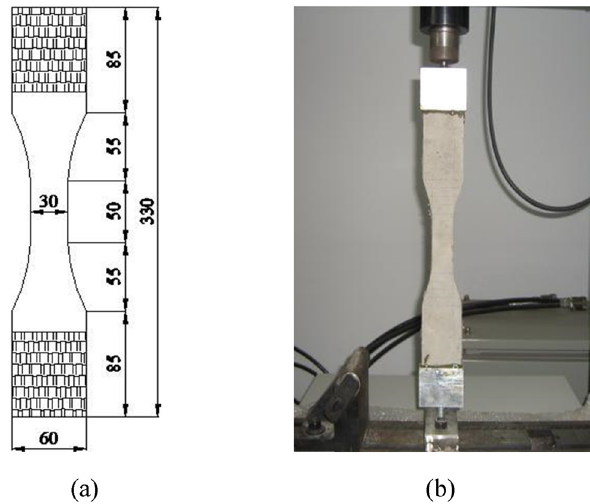
Figure 3: Loading instrument for tensile test. ( a ) Dimensions ( units: mm ) of dog - bone shaped specimens and ( b ) loading device.